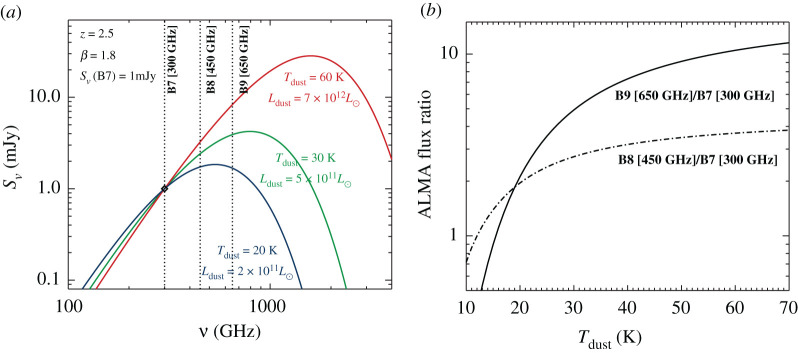
(a) Model dust SEDs showing a single modified black body spectrum at three different dust temperatures (at z = 2.5 and assuming a fixed dust emissivity index, β). An incorrectly assumed dust temperature for a galaxy (anchored by a single-band dust continuum measurement in Band 7) can change the derived FIR luminosity—and thus implied SFR—by an order of magnitude or more. Obtaining even one additional dust continuum measurement at a different frequency can help constrain the true dust SED, as shown in panel (b). While a longer lever-arm in frequency (e.g. including Band 9, solid line) would provide a stronger constraint at fixed S/N, atmospheric and configuration constraints must also be taken into account. The dashed line shows that with high enough S/N measurements, even a neighbouring band (Band 8) can help tightly constrain the dust temperature, and thus the implied dust luminosity and SFR. ALMA enables such studies in high-redshift galaxies on both global and resolved scales.